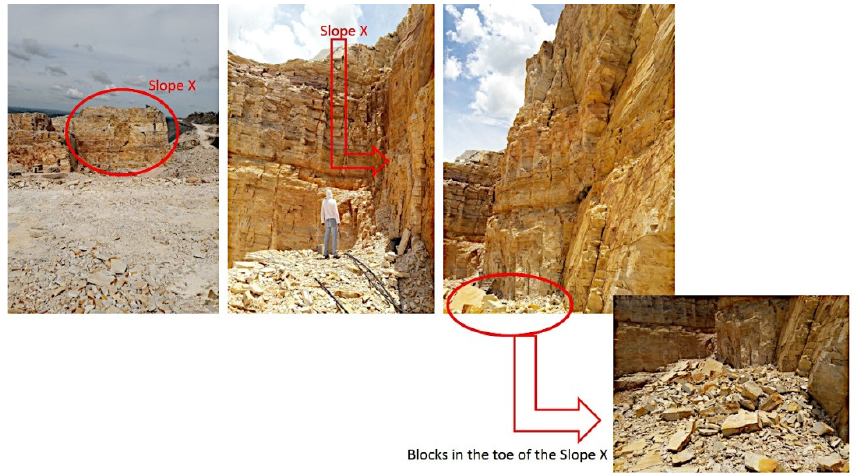
Figure 8. Slope X.